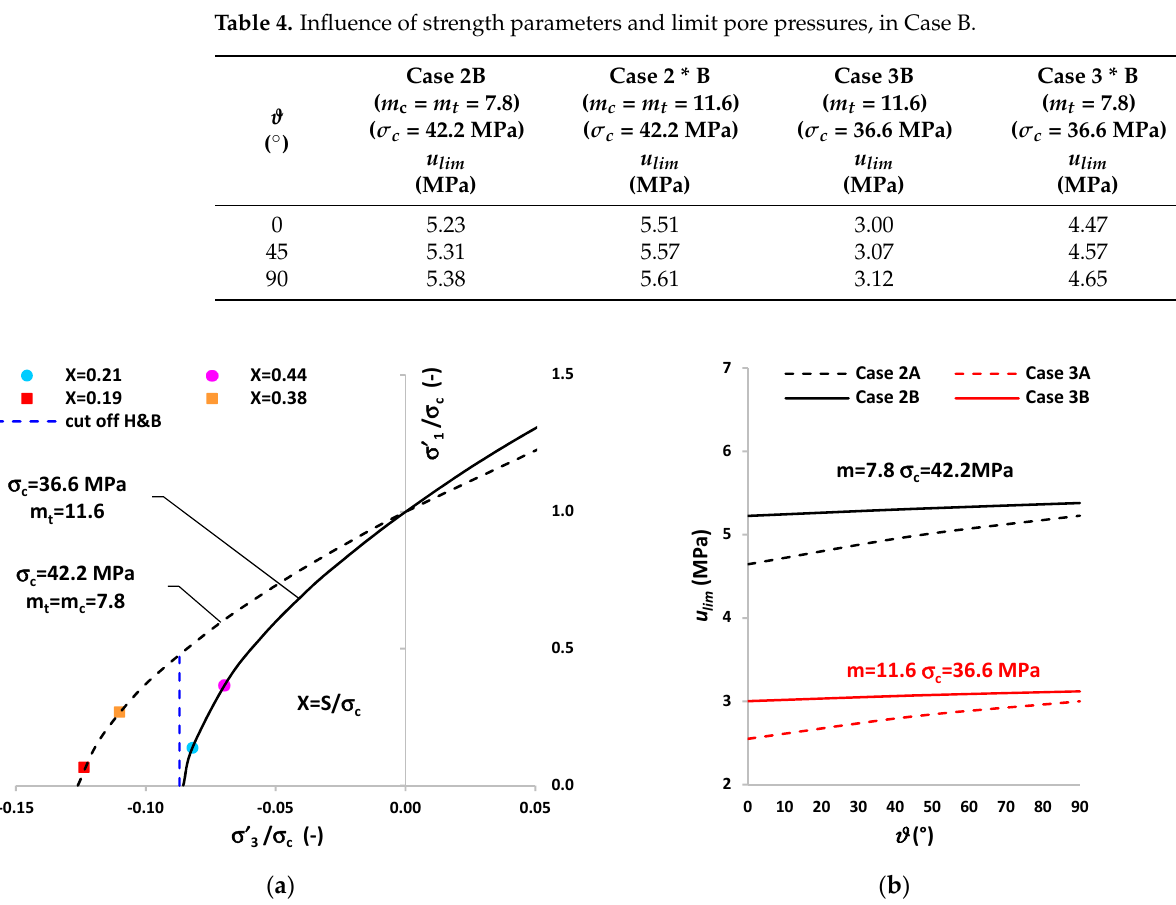
Figure 6. ( a ) Strength envelopes calculated with the different couples of m and σ c found in the data fitting (Case 2 and Case 3 in Figure 2b and Table 1). The filled symbols are the states of stress in the limit condition u lim at the tunnel boundary. The normalized states of stress are: σ ′ 1 / σ c =( S - u lim )/ σ c and σ ′ 3 / σ c =( P o - u lim )/ σ c =- u lim / σ c ; ( b ) Variation of u lim with ϑ (Tables 3 and 4).